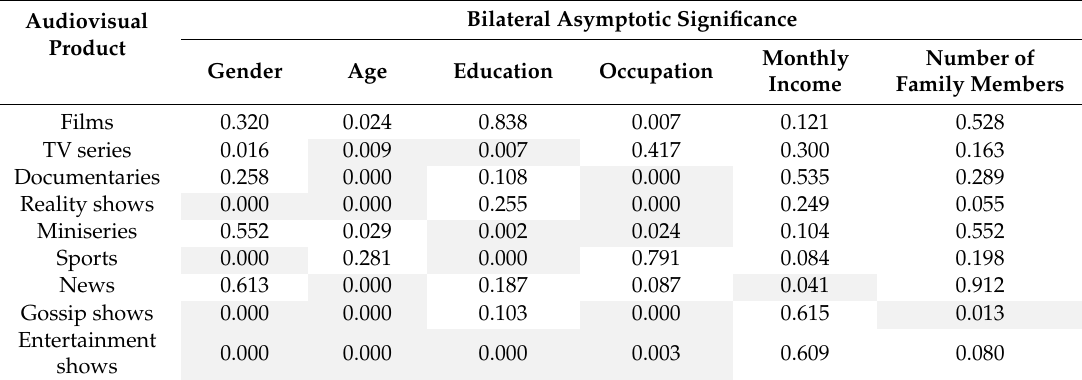
Table 10. Pearson’s chi-square test between audiovisual products and profile variables.